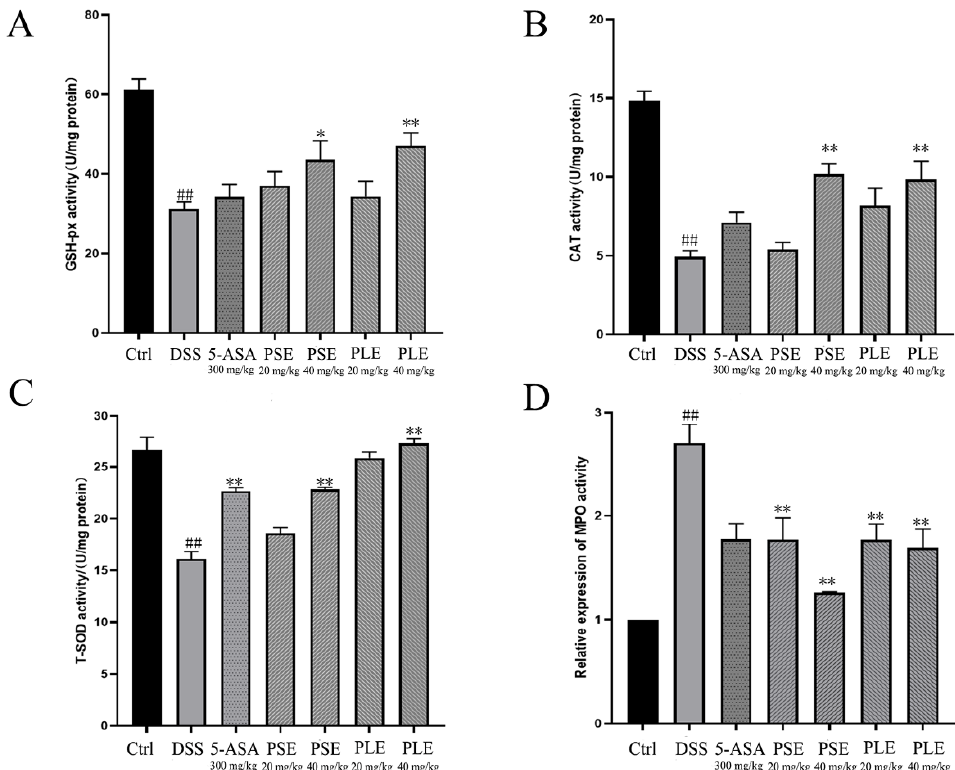
Figure 3. Effects of PSE and PLE on the activities of oxidation related enzymes in colon tissues of mice with DSS-induced colitis. Different groups of colonic sites were lysed using lysates and the glutathione peroxidase (GSH-Px) ( A ), catalase (CAT) ( B ), total superoxide dismutase (T-SOD) ( C ), myeloperoxidase (MPO) ( D ) activities in the colon tissues were measured. Data are represented as mean ± SD of three experiments. ## p < 0.01 vs. Control (Ctrl), * p < 0.05, ** p < 0.01 vs. model group (DSS) .